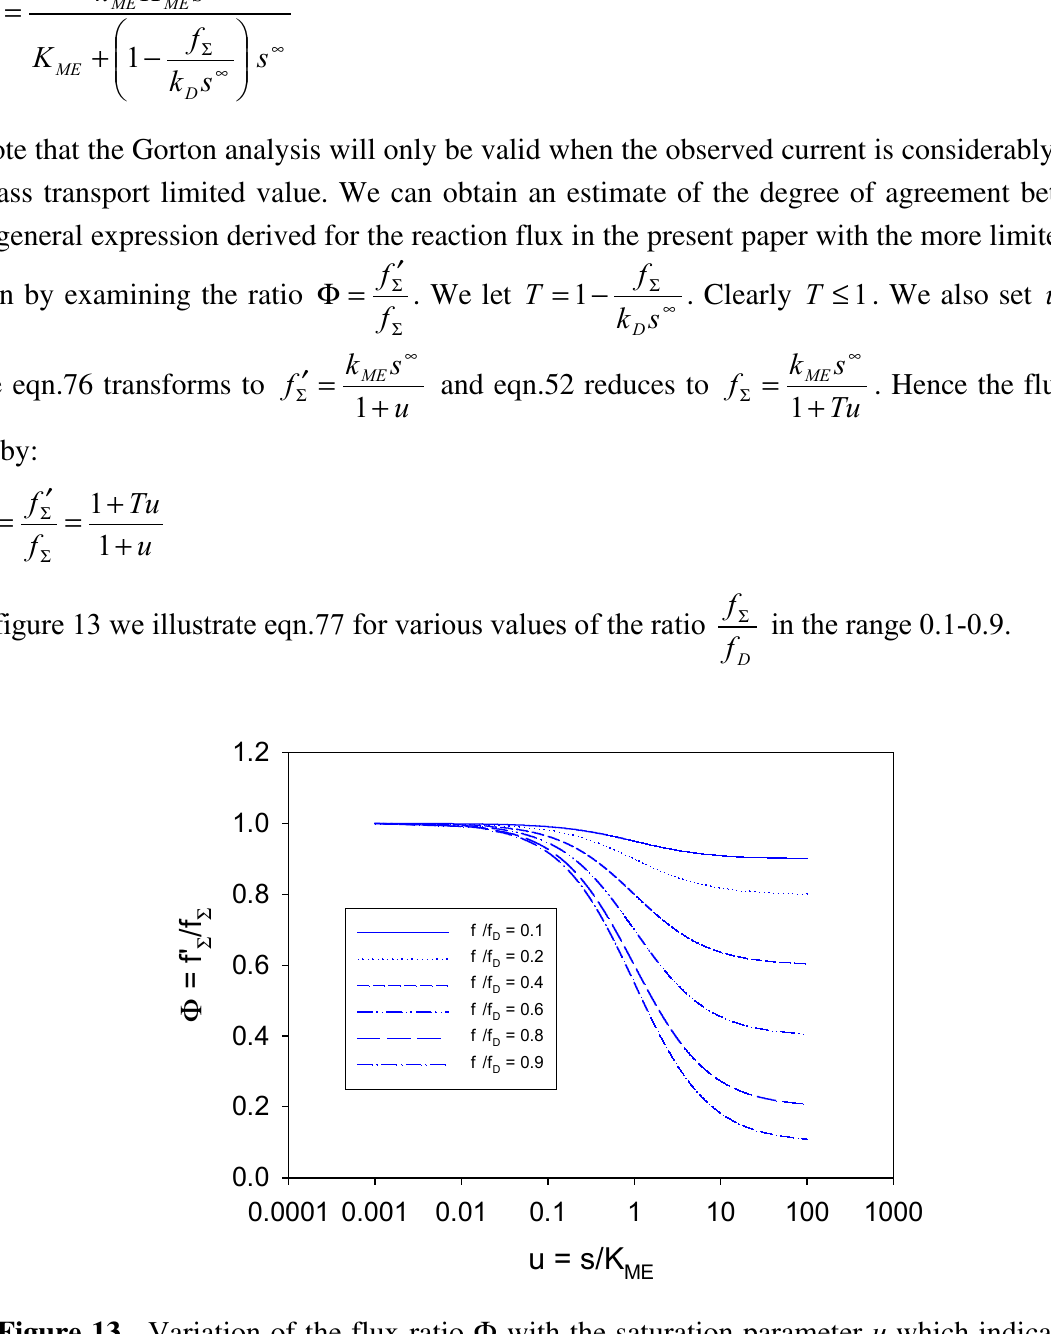
Figure 13. Variation of the flux ratio Φ with the saturation parameter u which indicates the region of validity of the Gorton